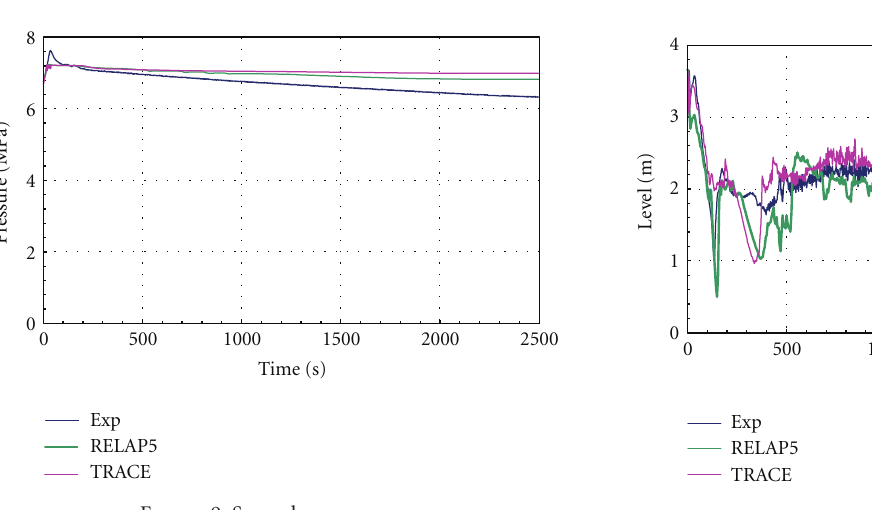
Figure 12: Core-collapsed liquid level.